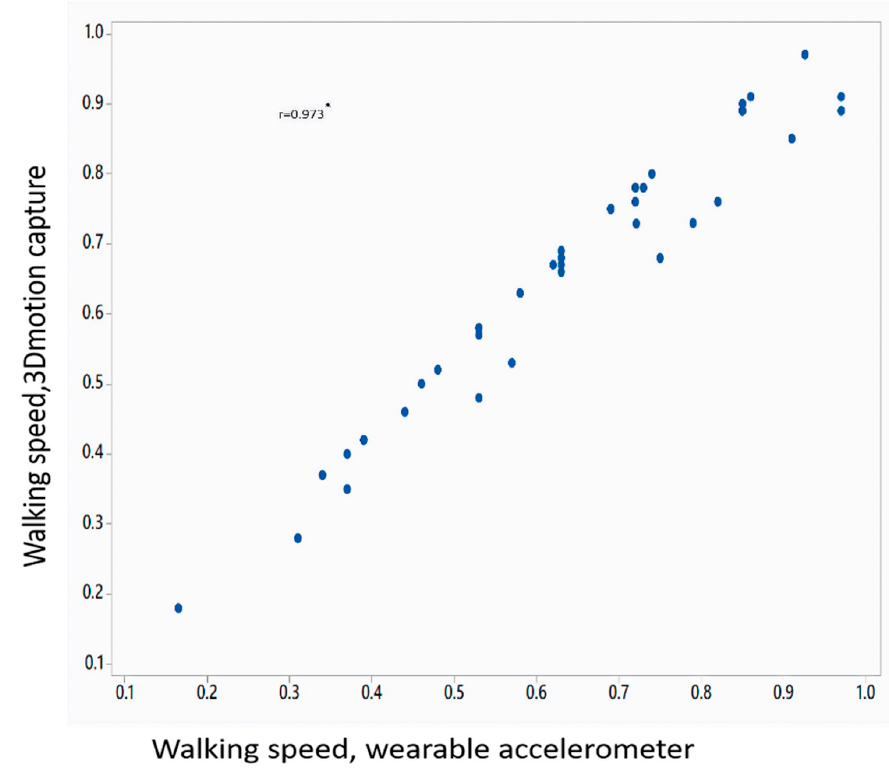
Figure 9. Correlation plot of walking speed estimated from wearable accelerometer-based approach and 3D motion capture system (* p < 0.01).